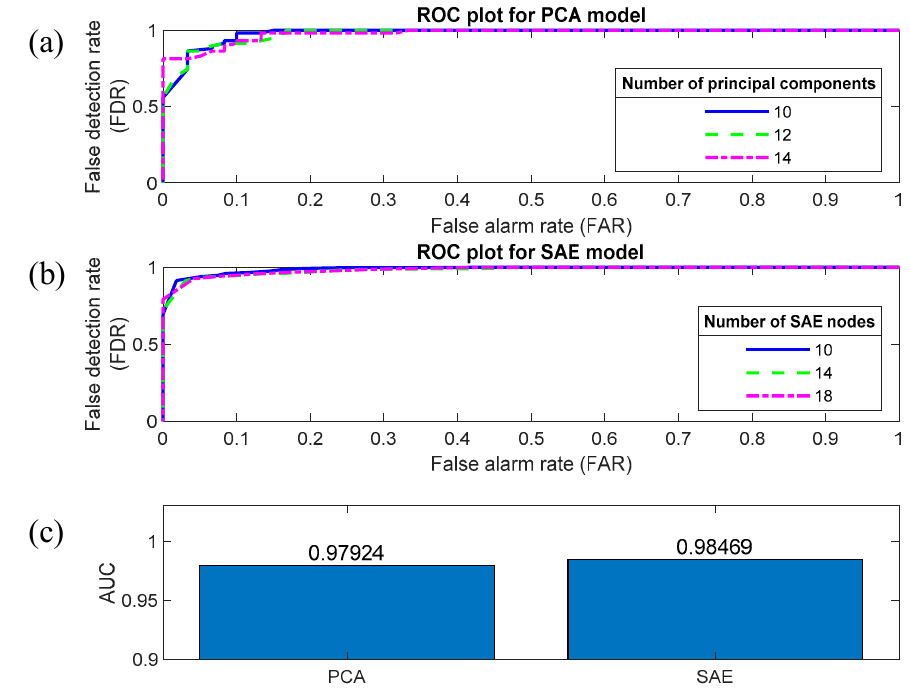
Figure 9. ROC curves and average AUC values: ( a ) ROC curves for the PCA model with a different number of principal components; ( b ) ROC curves for the SAE model with different number nodes in the hidden layer; ( c ) average AUC values of PCA and SAE models.